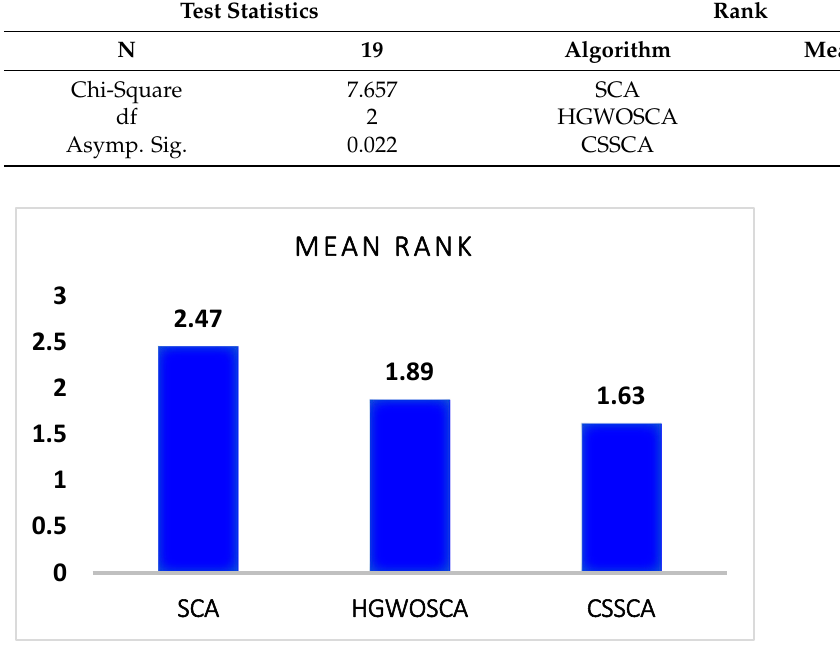
Figure 4. SCA, HGWOSCA, and CSSCA’s mean rankings in the Friedman test.